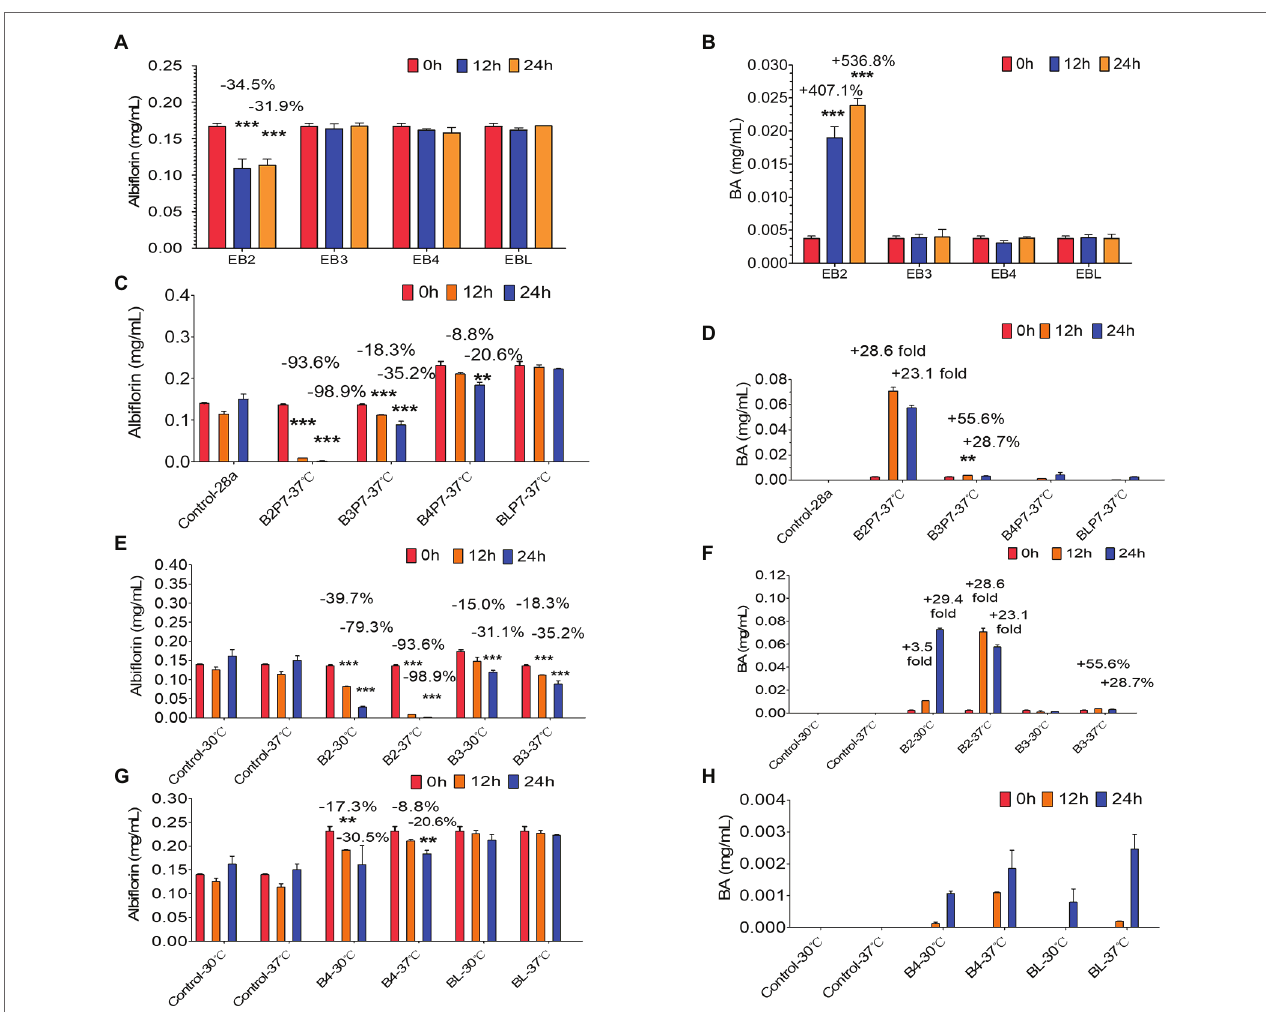
FIGURE 3 | Albiflorin metabolism by four esterases (B2, B3, B4, and BL). (A) Conversion of albiflorin in Escherichia coli stains (EB2, EB3, EB4, and EBL). (B) Benzoic acid (BA) generated by the E. coli strains (EB2, EB3, EB4, and EBL). (C) Conversion of albiflorin by four esterases. (D) Benzoic acid (BA) generated by four esterases. (E) Conversion of albiflorin by B2 and B3 at 30 ° C or 37 ° C. (F) Benzoic acid (BA) generated by B2 and B3 at 30 ° C or 37 ° C. (G) Conversion of albiflorin by B4 and BL at 30 ° C or 37 ° C. (H) Benzoic acid (BA) generated by B4 and BL at 30 ° C or 37 ° C (Student’s t -test, ** p < 0.01 and *** p < 0.001, data are expressed as the mean ±